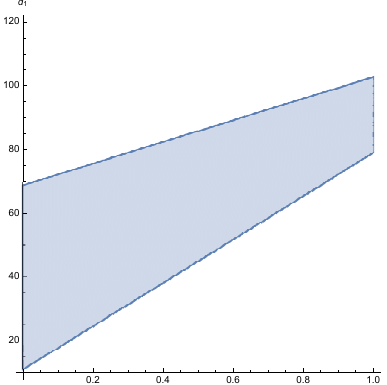
Figure 1. The region of ( r 1 , d 1 ) defining the core in Example